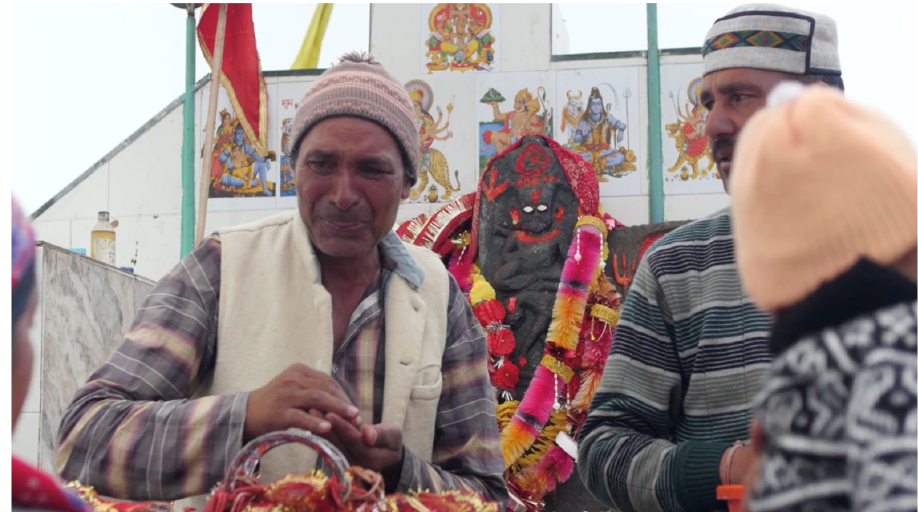
Figure 7. Pilgrim, embodying the goddess, chastises his supplicant-wife. The temple priest (top right) and grandson (bottom right) partake in the drama. Credit: Nadav Harel.